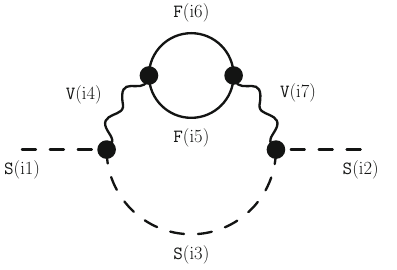
Fig. 5 Each Feynman diagram can be uniquely identified by the list of its edges when interpreted as a graph. Each edge has three argu- ments: a starting vertex, an ending vertex, and a label (describing field type and propagator index). The vertices v[ i ] are numbered consecu- tively, i ∈ N . The starting vertices of external fields are not connected to